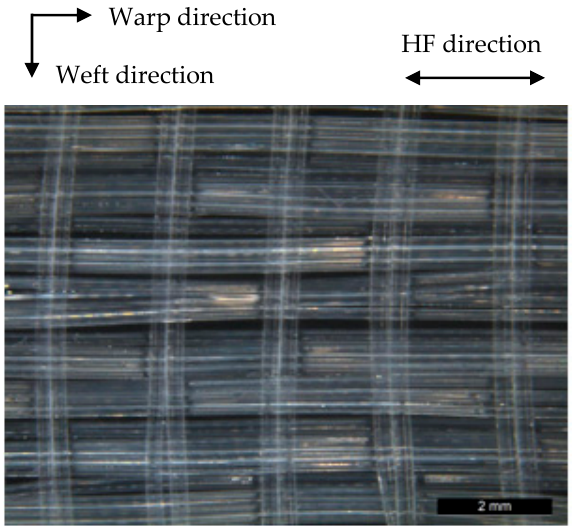
Figure 4. Woven HF fabric.